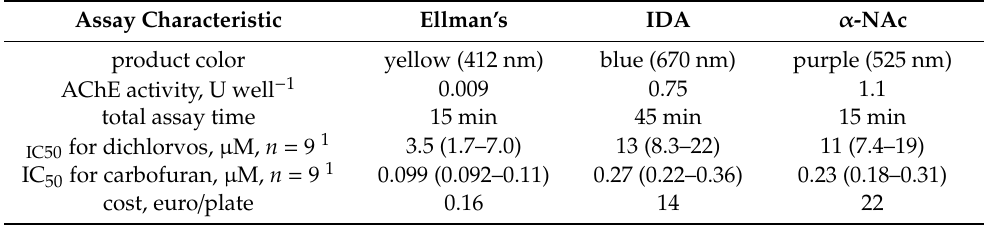
Table 1. Critical comparison of Ellman’s, IDA and α -NAc